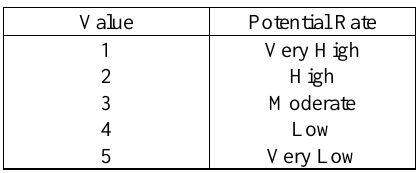
Table 1. Assumed weights of various Layers